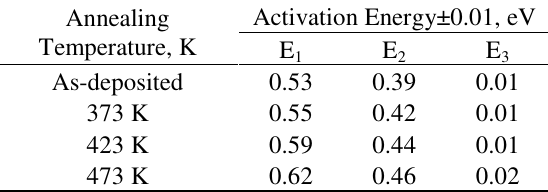
Table 2. Variations of activation energies with annealing temperatures